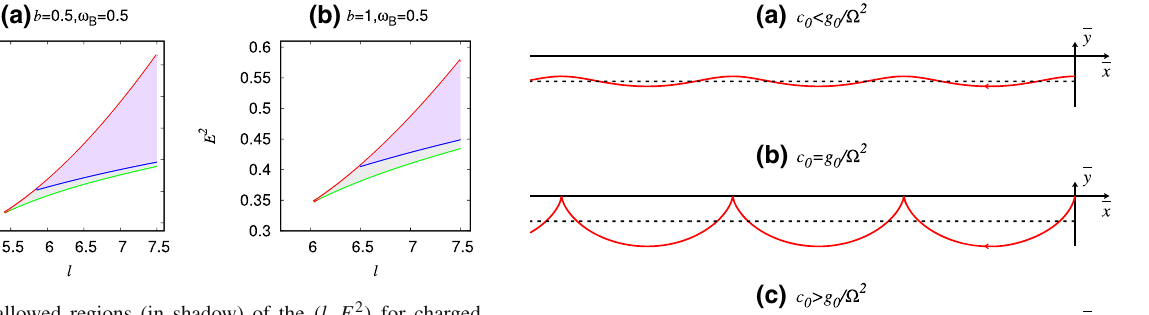
Fig. 8 The allowed regions (in shadow) of the ( l , E 2 ) for charged particles’ bound orbits around quantum-corrected Schwarzschild black holes immersed in an external asymptotically uniform magnetic field with two cases: (a) b = 0 . 5 , ω B = 0 . 5; (b) b = 1 , ω B = 0 . 5. The red curves denote E 2 max and the green curves denote E 2 curves denote the critical energy E 2 c